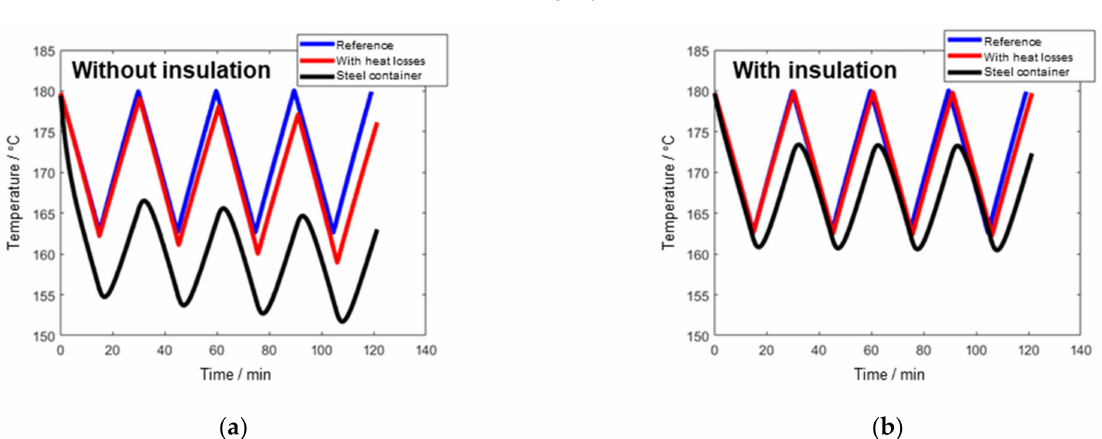
Figure 15. Cyclic temperature curves with different configurations: ( a ) Without insulation; ( b ) With